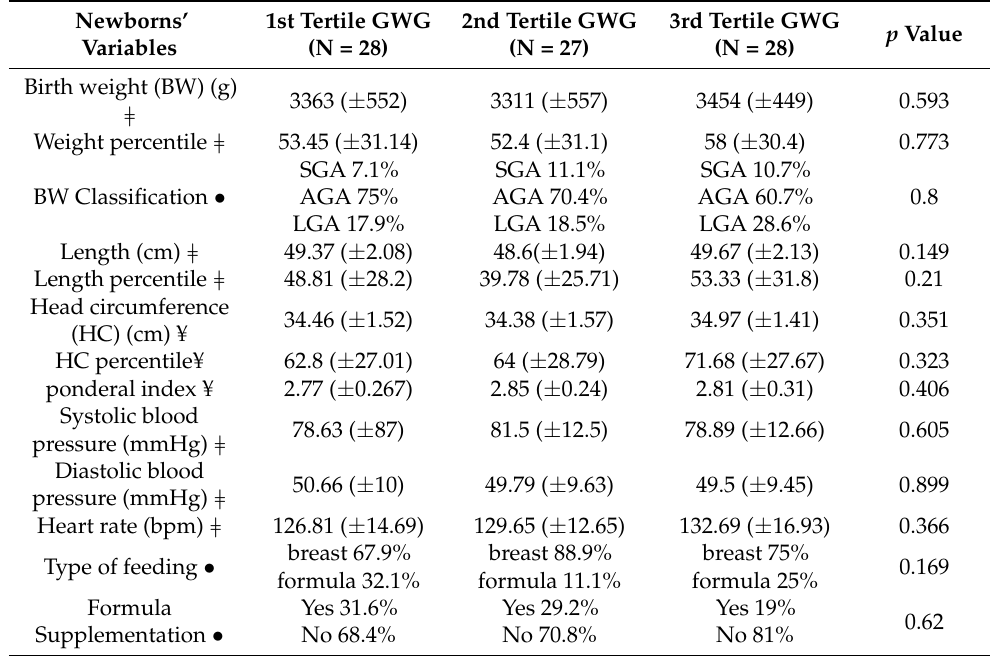
Table 2. Characteristics of children at birth, according to absolute maternal GWG tertiles. Data are presented as either mean ± SD or no. (%). } Analysis of variance (ANOVA). ¥ The Kruskal Wallis test. • Chi-squared test. Data with significant p -values are labelled as